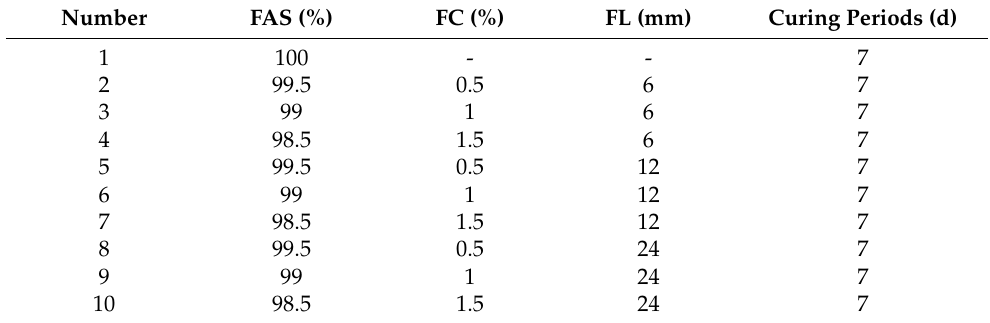
Figure 3. ( a ) Standard compaction curves and ( b ) Relation of shear stress peak value and fly ash content under different normal stress. Table 4. Designation of the specimen.